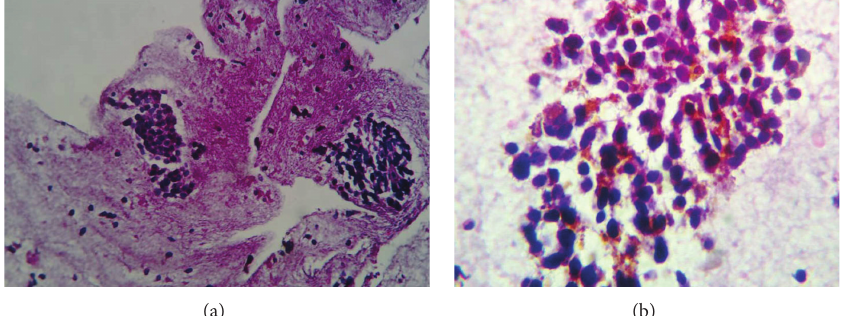
Figure 4: (a) Small nests of cohesive malignant cells within areas of hemorrhage [H & E 100x]. (b) Higher magnification detailing the cell morphology of spindle to oval shaped cells [H & E